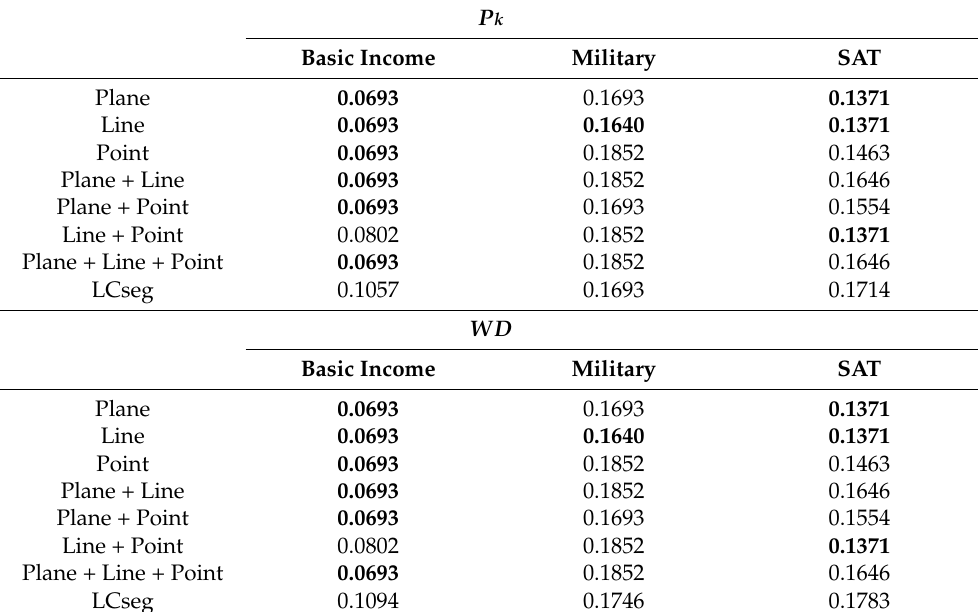
Table 5. CSseg P k and WD values with the weight of self-continuity set to